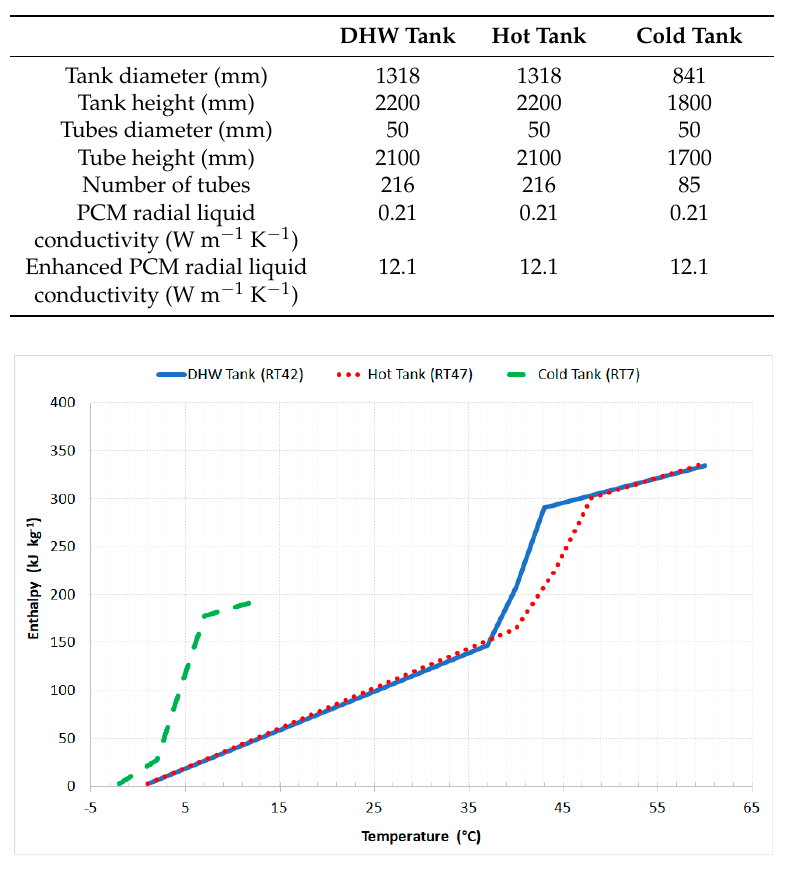
Figure 10. Enthalpy–temperature curves for the paraffin used in the simulations.